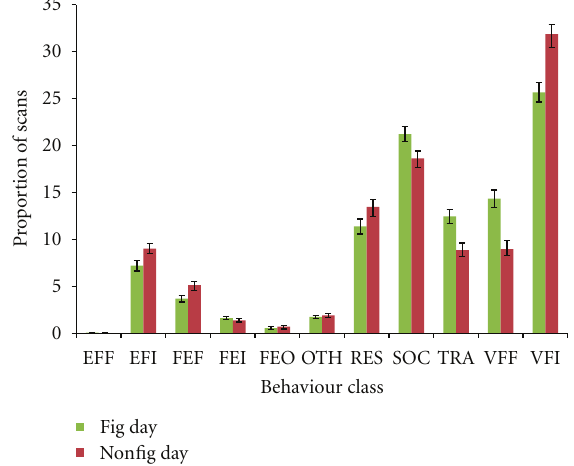
Figure 2: Proportion of scan samples taken at 30-minute intervals dedicated to di ff erent behaviour classes by white-faced capuchin monkeys in Sector Santa Rosa, ACG, Costa Rica. EFF: extractive foraging fruit; EFI: extractive foraging invertebrate; FEF: feeding fruit; FEI: feeding invertebrate; FEO: feeding other; OTH: other behaviour; RES: resting; SOC: social; TRA: traveling; VFF: visually foraging fruit; VFI: visually foraging